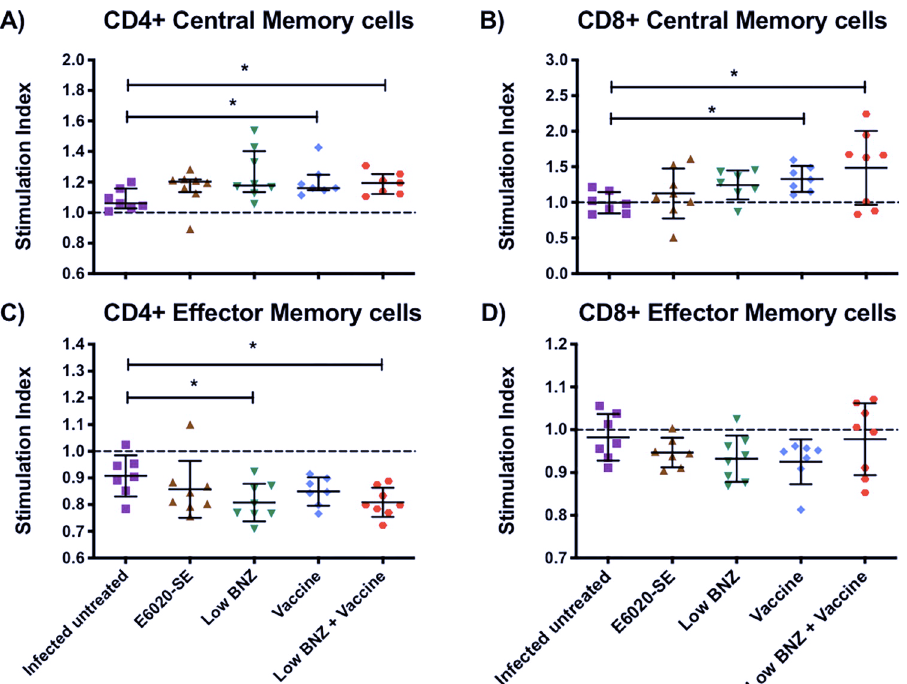
Fig 5. Effect of vaccine-linked chemotherapy on antigen-specific CD4 + and CD8 + T cells memory response. Mononuclear cells isolated from mice at 200 days p.i. were co-cultivated with macrophages stimulated in vitro with TSA-1-C4+Tc24-C4 (25 μ g/mL) for 96 h. Data were analysed using FlowJo X software. Stimulation index of antigen- specific ( A ) CD4 + Central Memory, ( B ) CD8 + Central Memory, ( C ) CD4 + Effector Memory and ( D ) CD8 + Effector Memory T cells are presented. Each point represents an individual mouse, horizontal lines denote mean ± SD or median ± interquartile ranges values according to the normality of the data. Data were analysed using Student´s t-test or Mann-Whitney U-test. Significance is indicated as follows � , P �